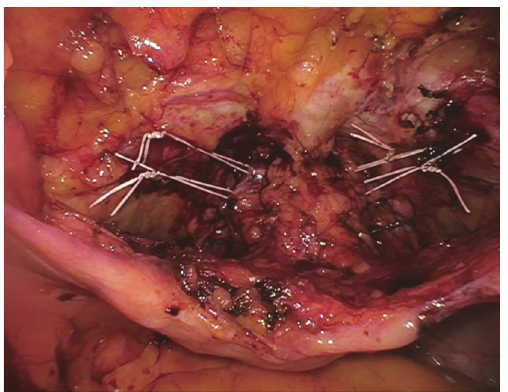
Figure 4: Laparoscopic Burch urethropexy with a paravaginal repair following sling removal. Permission to reprint from Miklos and Moore.